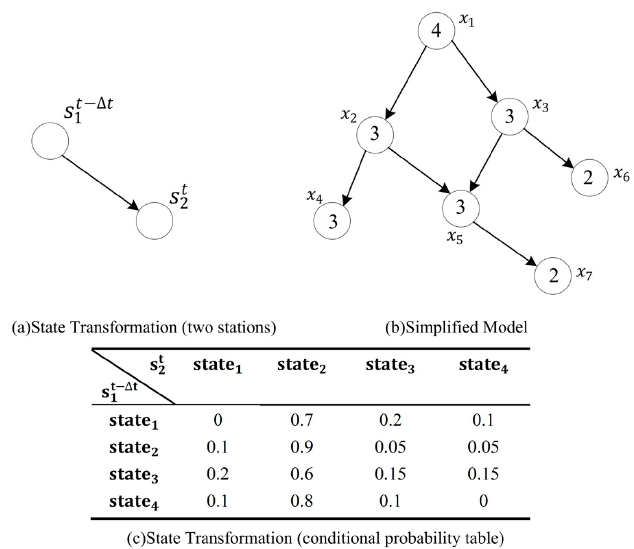
Figure 2. State transformation between stations. ( a ) represents state transformation between two stations; ( b ) represents the simplified model of a sensor network; and, ( c ) represents the conditional probability table of two stations. s t is the state of downstream station at time t , s t − is the state of its upstream station at t − ∆ t . x i represents the water quality detection station. The number in the circle in ( c ) represents the state of the station. state i ( i = 1, · · · ,4 ) represents four different kinds of state for each station.